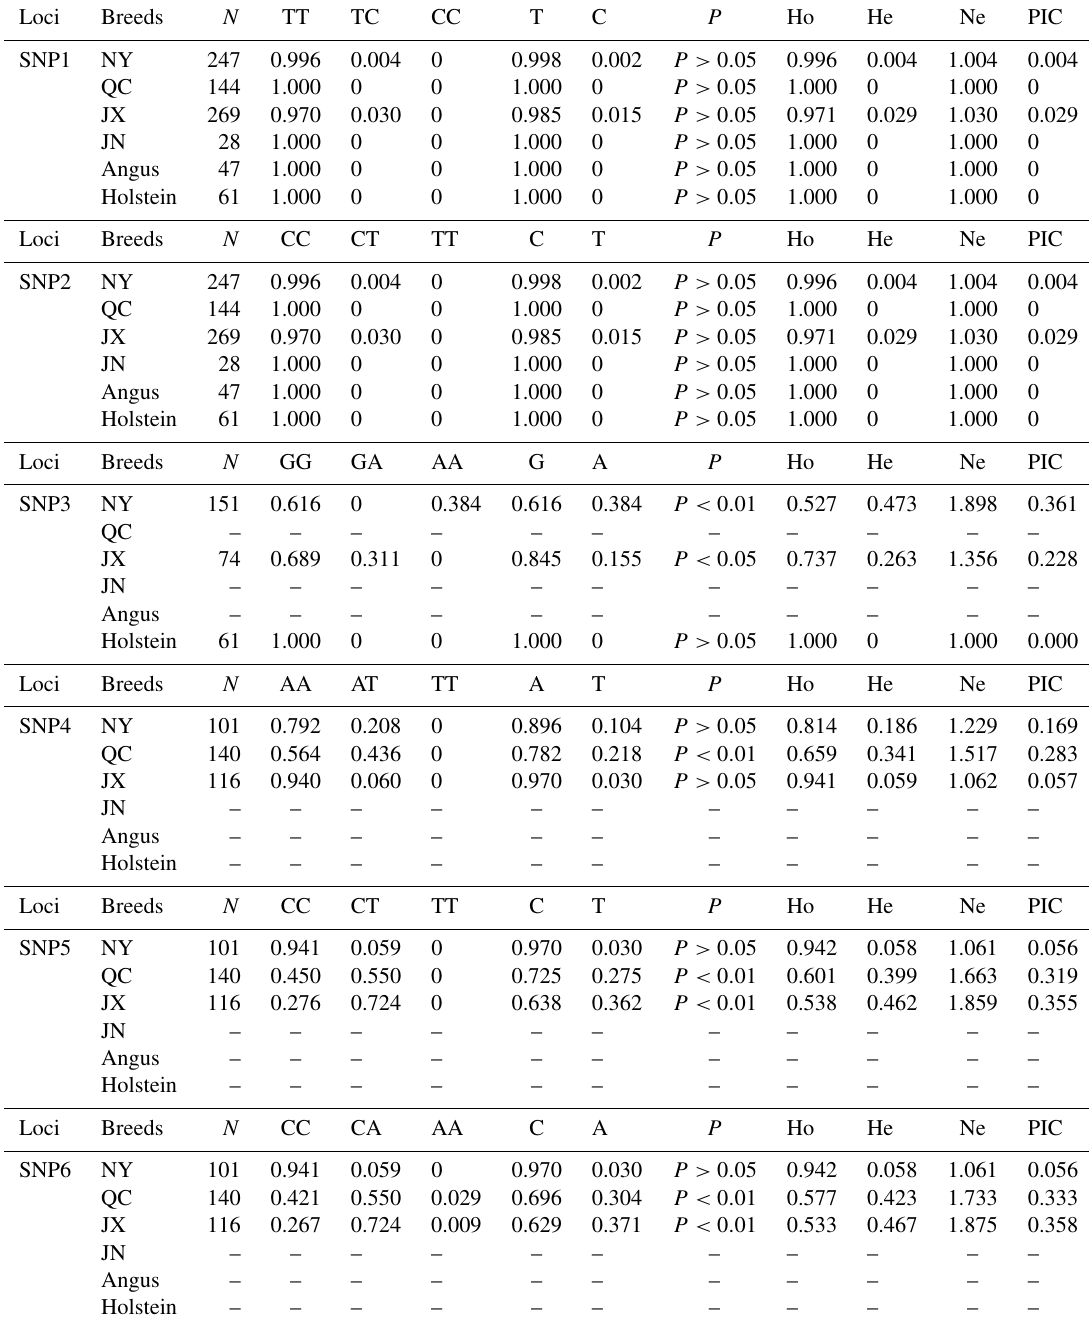
Table 3. Genotypic frequencies, allelic frequencies, HWE, and population parameters of the Nanog gene in Chinese cattle. Loci